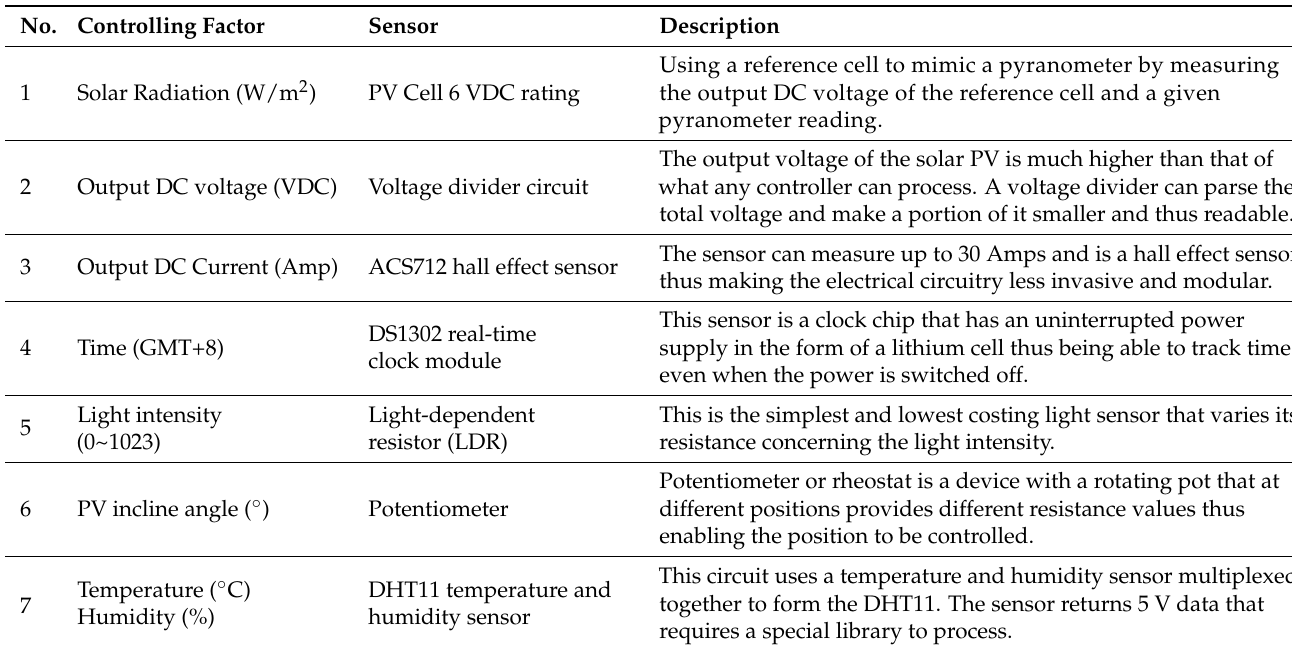
Table 1. Sensor selection criteria [19].